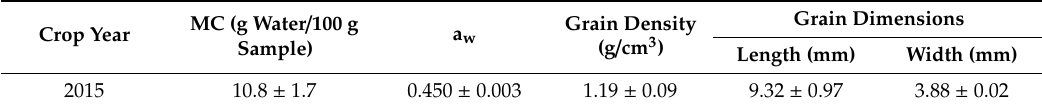
Table 1. Physicochemical specifications of barley